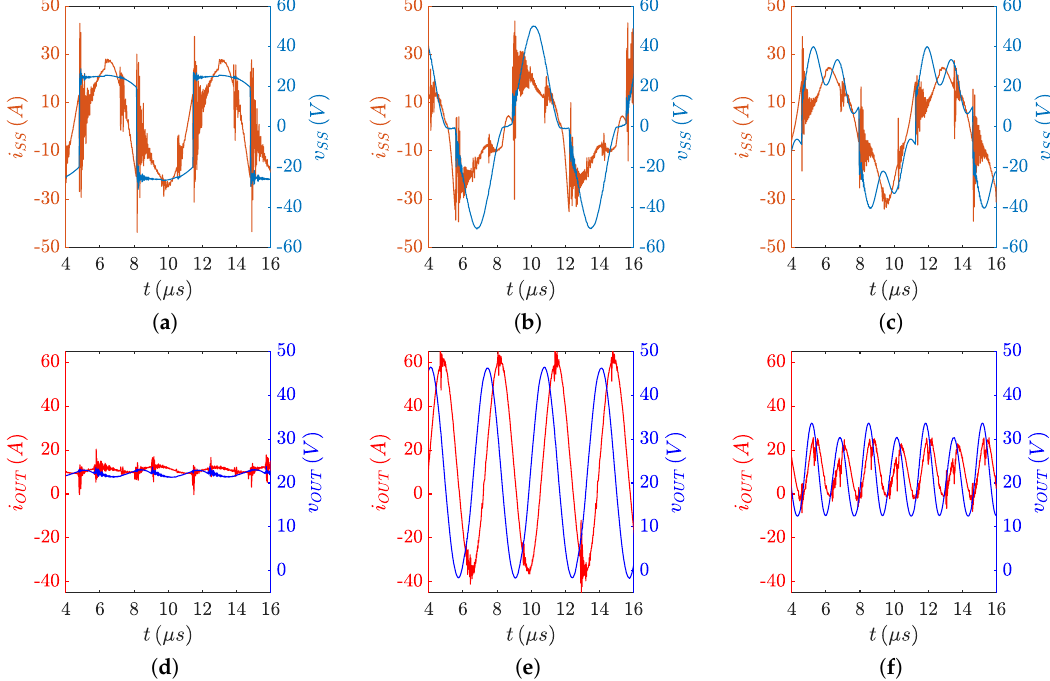
Figure 9. Waveforms of the voltage v SS ( t ) and current i SS ( t ) measured at the input of the bridge rectifier, with C 0 = 9.4µF ( a ), C 0 = 807nF ( b ) and C 0 = 220nF ( c ). Battery current i OUT ( t ) and voltage v OUT ( t ) for C 0 = 9.4µF ( d ), C 0 = 807nF ( e ) and C 0 = 220nF ( f